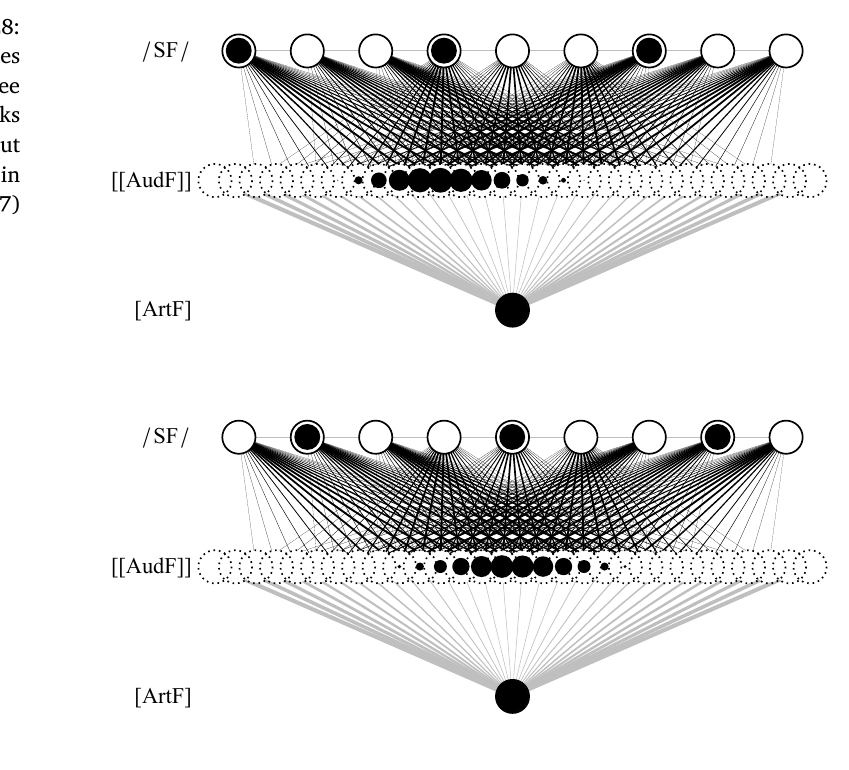
Figure 28: Output activities for the three categories (peaks in input distribution as in Figure